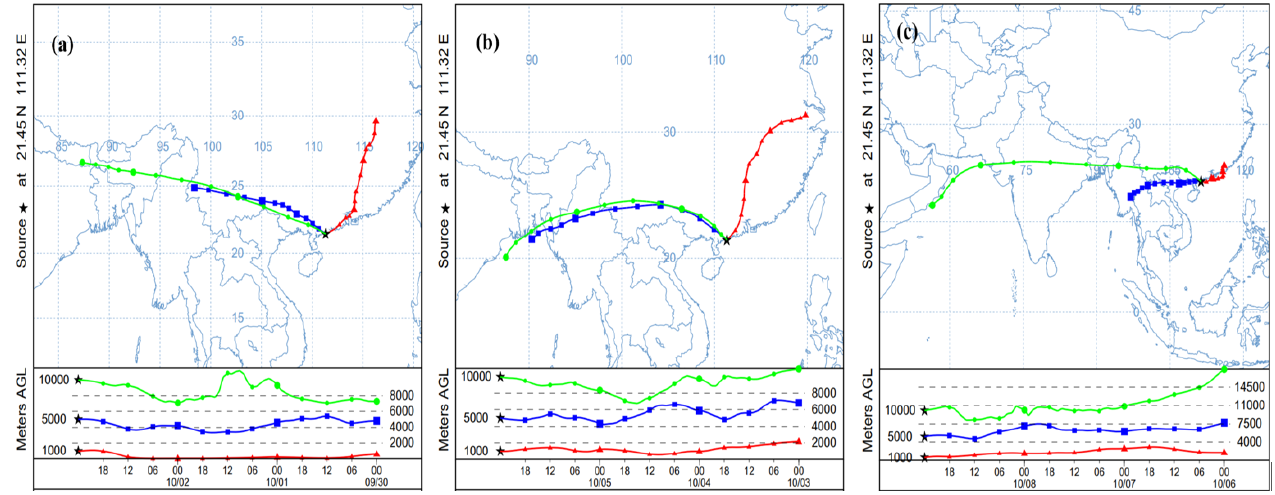
Figure 9. Cluster analysis of 72 h back trajectories of Maoming from 30 September–8 October, 2018, ( a ) 30 September–2 October, ( b ) 2–5 October, ( c ) 6–9 October.